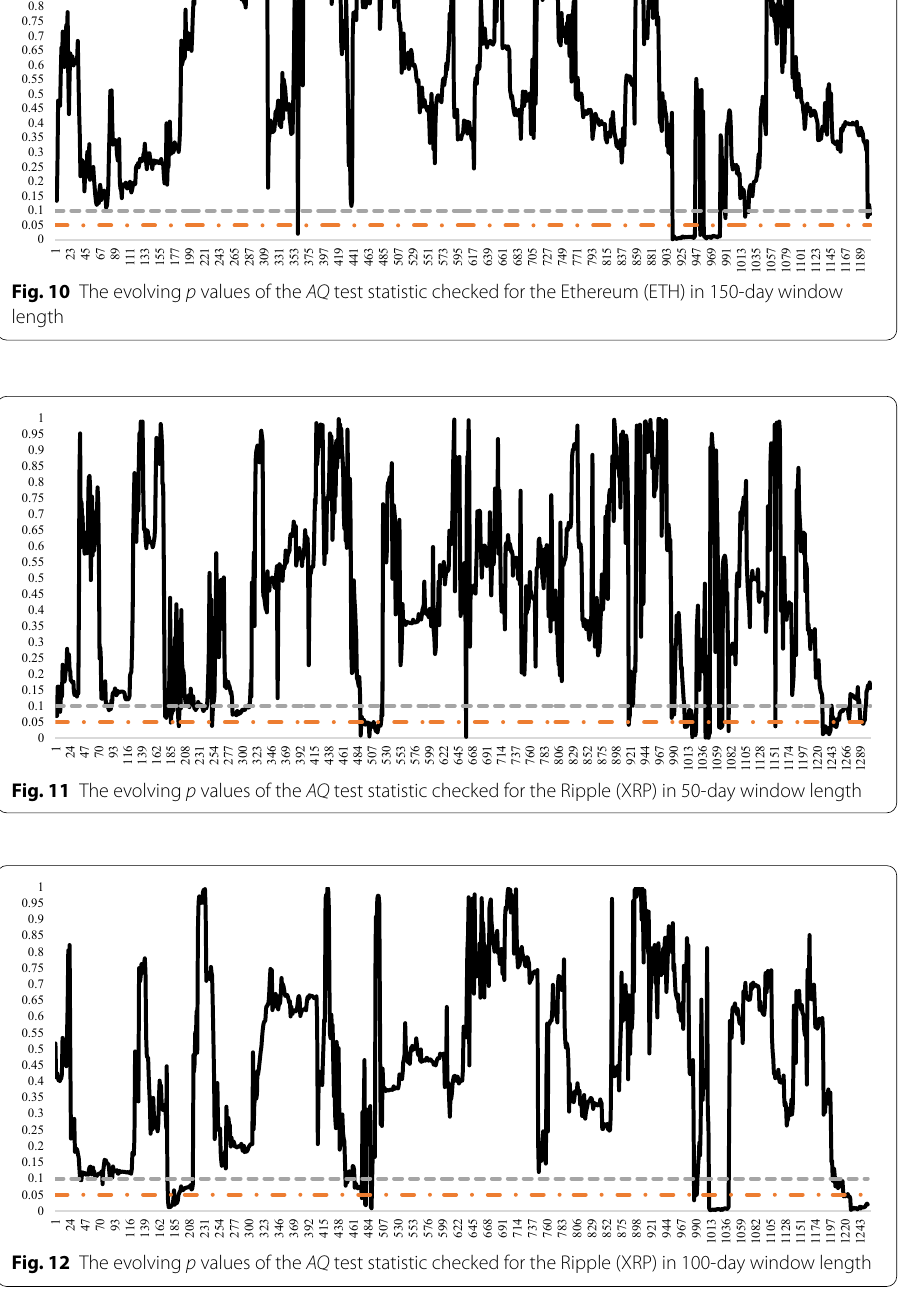
intervals (Figs. 9, 10), this trend was apparent in the last observations, and as shown in Fig. 10, the market remained inefficient within the 150-day window.